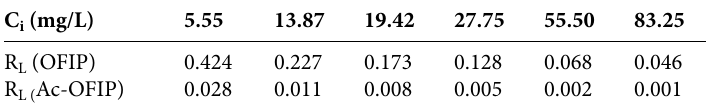
Table 2. R L as a function of the initial concentration of